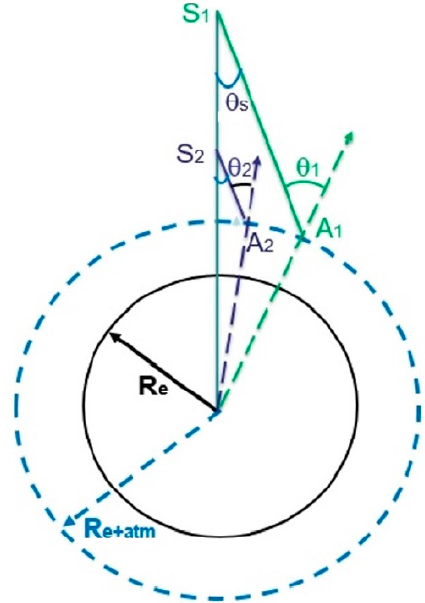
Figure 1. A diagram illustrating the satellite-surface viewing geometry. It is noted that, for satellites at di ff erent altitudes with the same downward view zenith angle, the view zenith angles at the top of the atmosphere are di ff